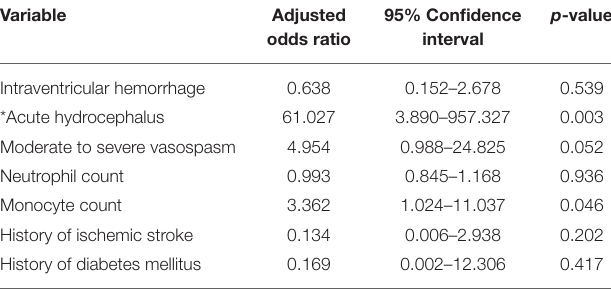
( Table 4 ). Monocyte count trended toward significance